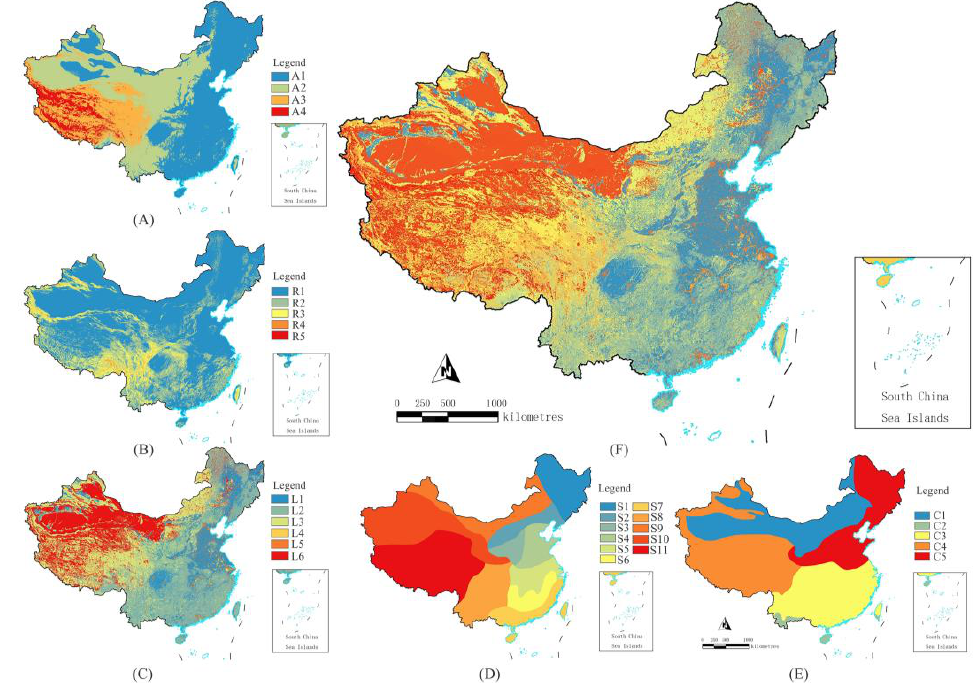
Figure 3. Attribute classification of natural and human factors and 2307 kinds of landscape description units: ( A ) altitude type classification, ( B ) topographic relief type classification, ( C ) land-use type classification, ( D ) settlement type classification, ( E ) climate type classification, and ( F ) showing 2307 kinds of landscape description units (LDUs).